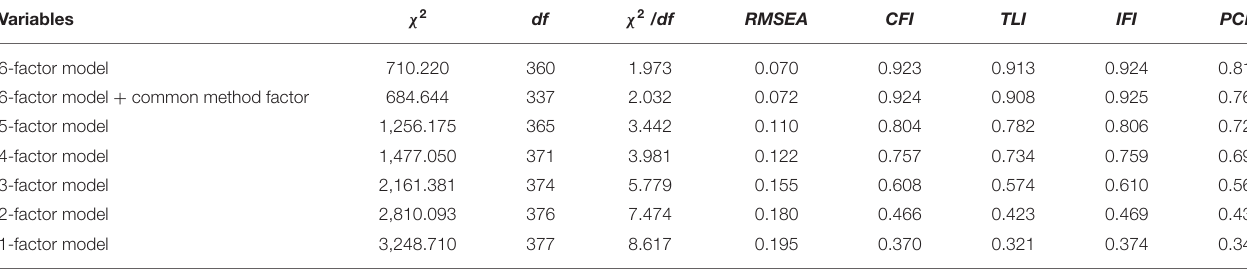
TABLE 3 | Confirmatory factor analysis results ( N = 201).